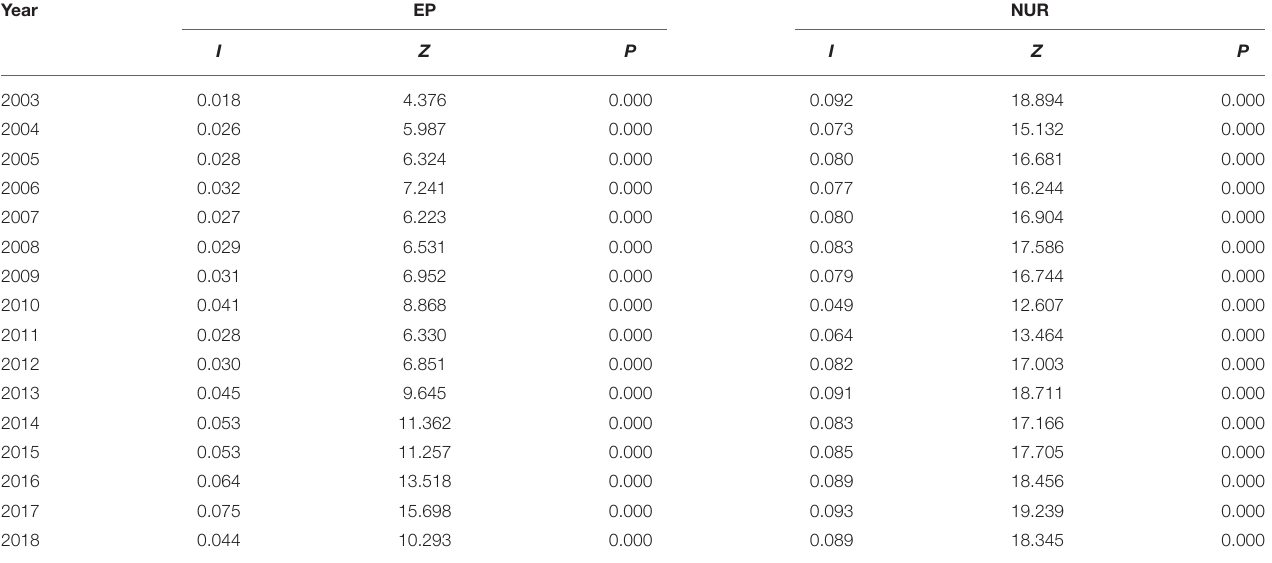
TABLE 4 | Global correlation test—Moran